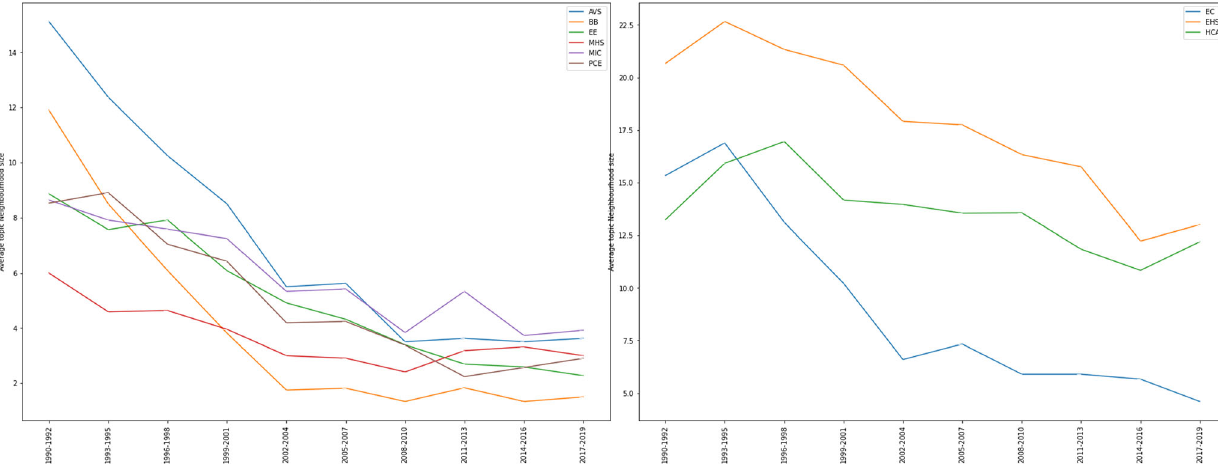
Fig. 3 Average neighbourhood size of FoR embeddings over time, by cluster. The left panel shows clusters of STEM disciplines. ‘ AVS ’ stands for Agricultural and Veterinary sciences, ‘ BB ’ stands for Biological and Biotechnological Sciences, ‘ EE ’ stands for Engineering and Environmental Sciences, ‘ MHS ’ stands for Medical and Health Sciences, ‘ MIC ’ stands for Mathematical, Information and Computing Sciences, and ‘ PCE ’ stands for Physical, Chemical and Earth Sciences. The right panel shows clusters of HSS disciplines. ‘ EC ’ stands for Economics and Commerce, ‘ EHS ’ stands for Education and Human Society, and ‘ HCA ’ stands for Humanities and Creative Arts (see Supplementary Table